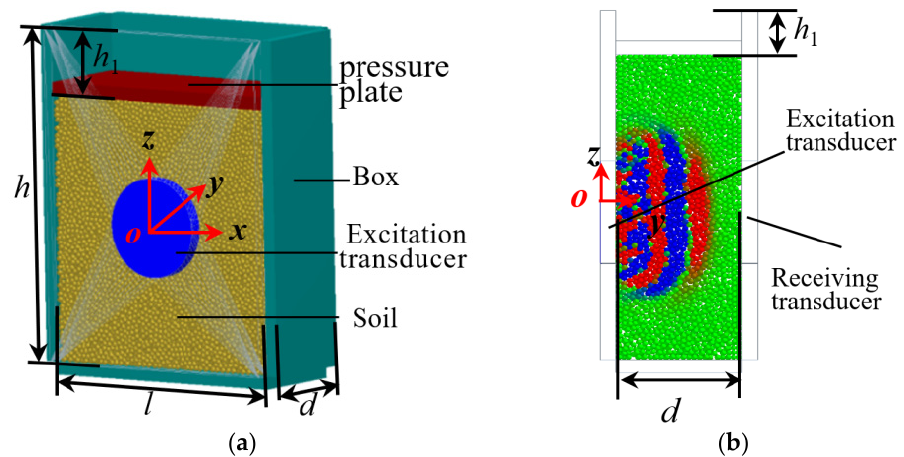
Figure 2. DEM model. ( a ) 3D model; ( b ) Side view and acoustic wave propagation